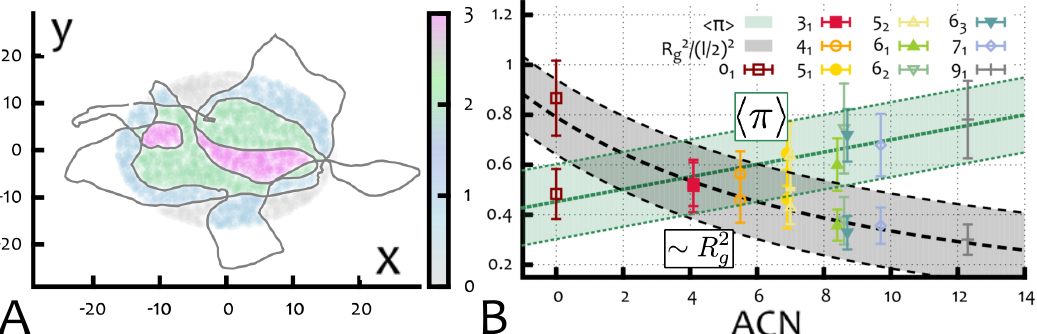
Figure 5. ( A ) Entanglement field π ( x , y ) over a disk D for a 9 1 knot whose projection is traced as a grey curve. ( B ) Entanglement number (cid:104) π (cid:105) and radius of gyration (squared) R 2 g / ( l /2 ) 2 as a function of the average crossing number ACN . Here l is the lattice spacing of the model gel. Data points correspond to the value taken by various knot types ranging from 0 1 to 9 1